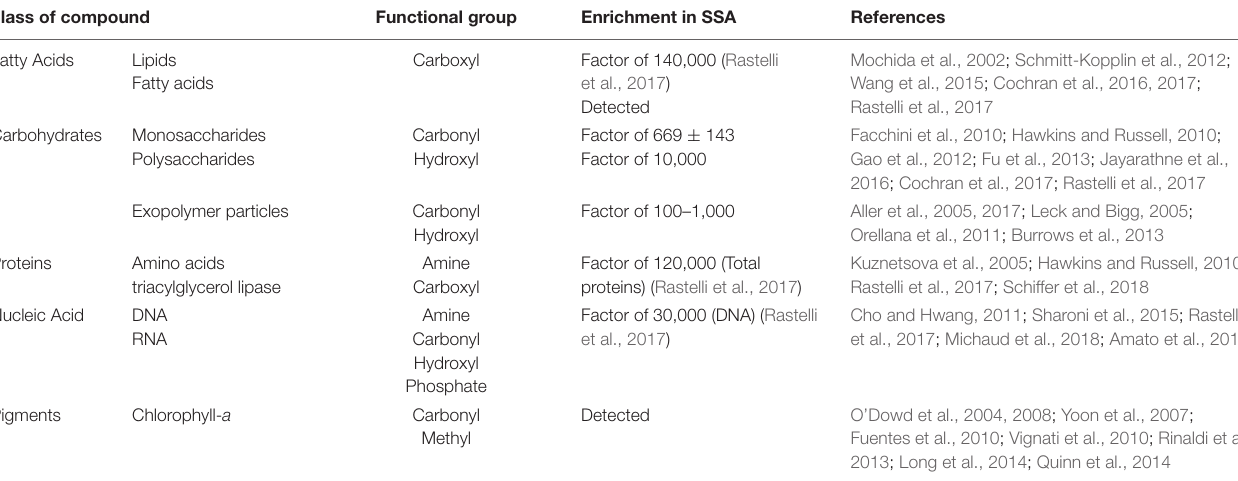
TABLE 1 | Organic compounds observed in marine aerosol.